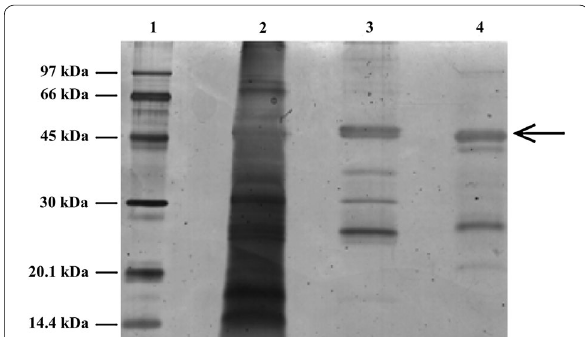
Fig. 4 Silver-staining SDS-PAGE from tobacco proteins purified with concanavalin affinity chromatography. Lane 1: Low molecular weight marker (GE Healthcare, UK); lane 2: total soluble proteins from transgenic tobacco seeds (event T-APA1); lane 3: eluted fraction after ConA Sepharose purification; lane 4: 500 ng of purified native APA protein from M. tuberculosis . The position of the recombinant APA protein is indicated with an arrow